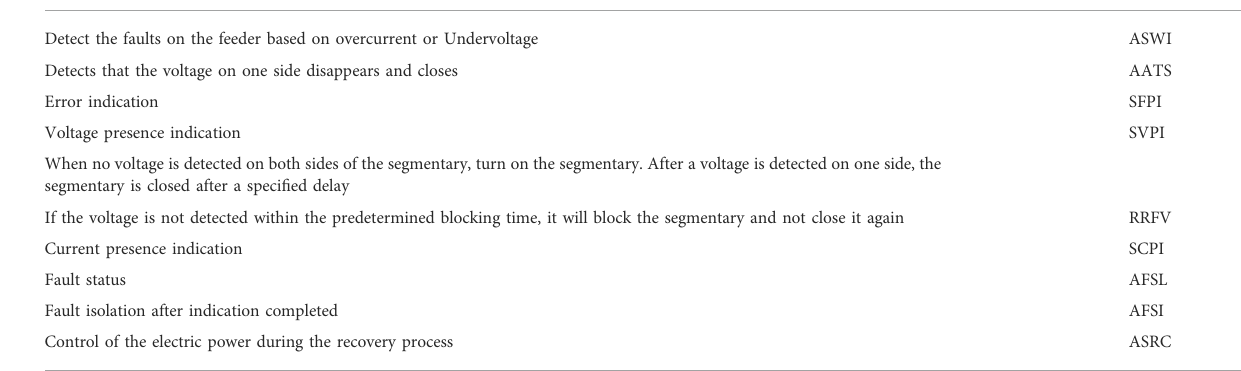
TABLE 3 New logic nodes for electric power supply restoration in IEC 61850 –